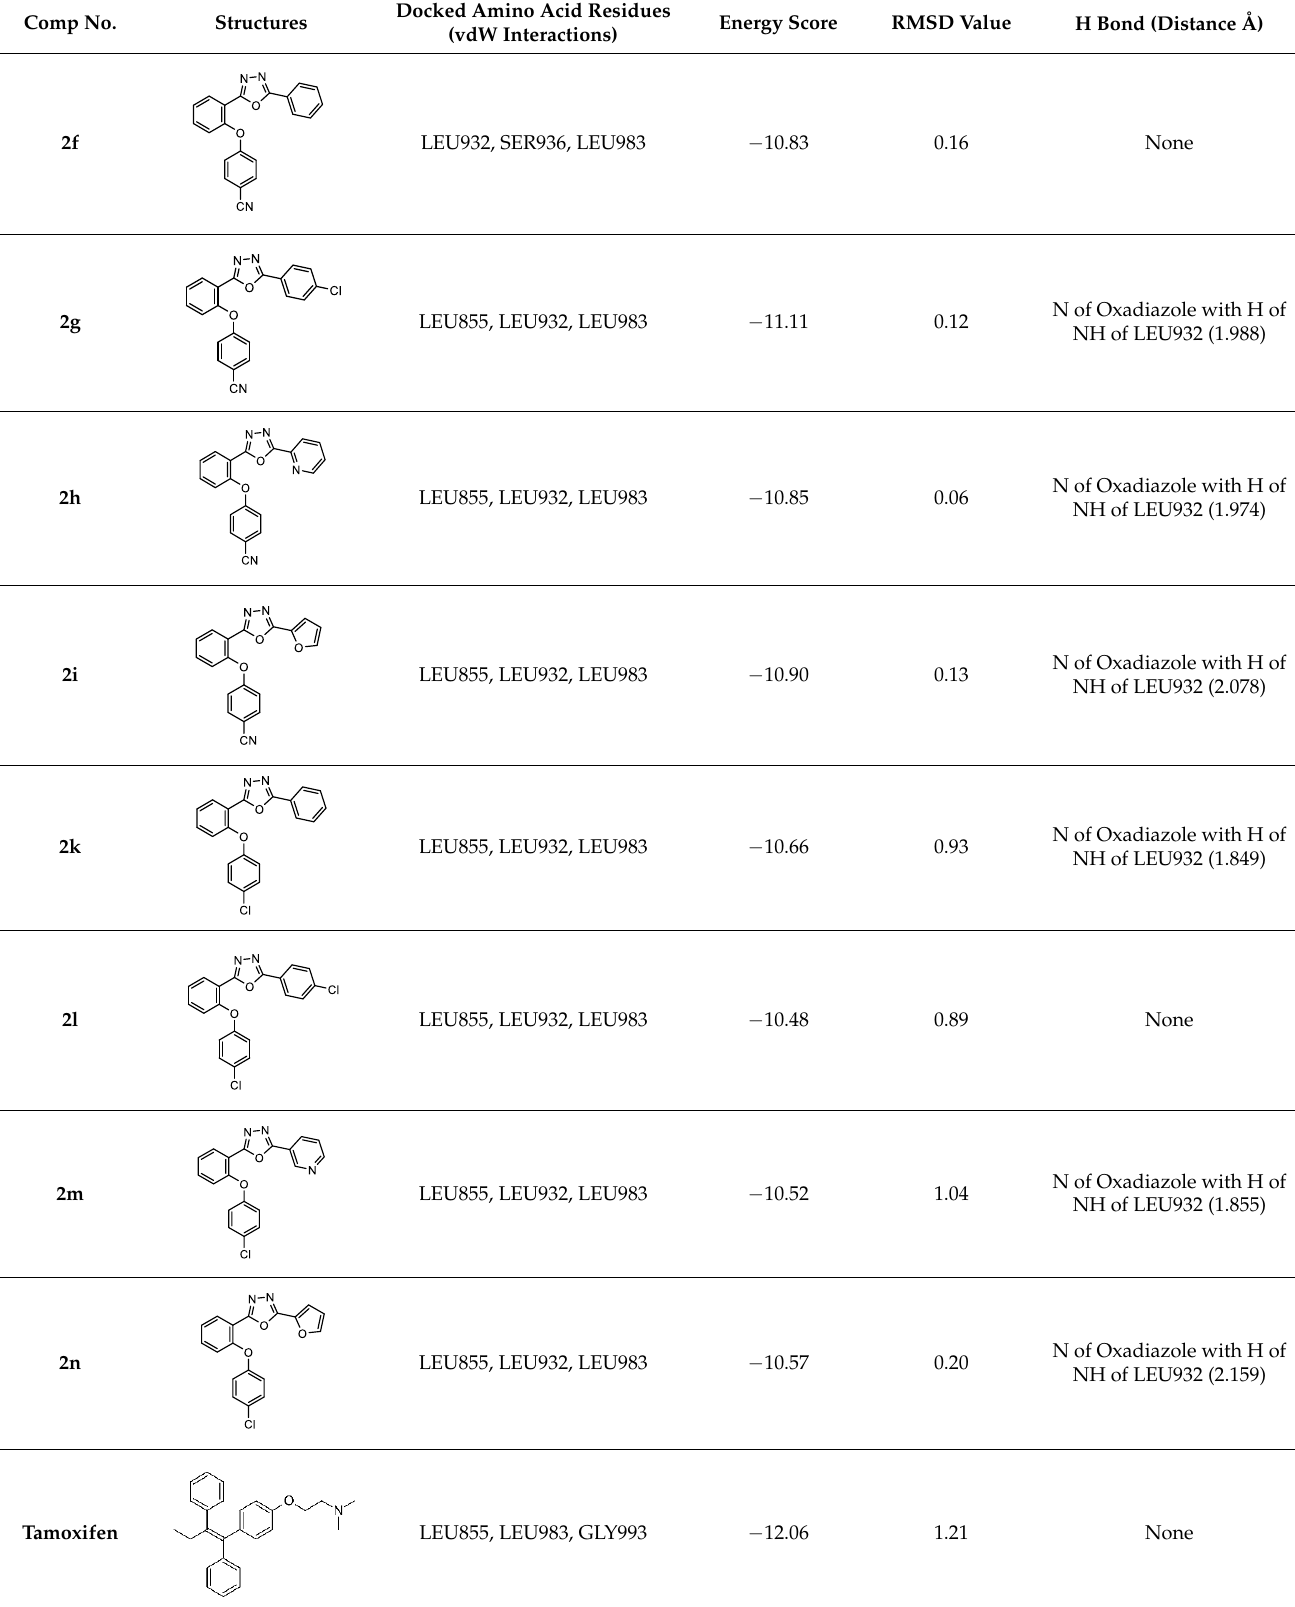
Table 4. Docking results of Janus kinase 2 (3KRR).